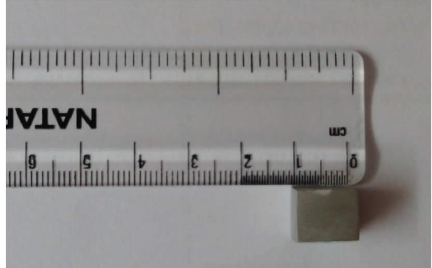
Figure 1: Cut portion of the composite sample for the corrosion experiment.